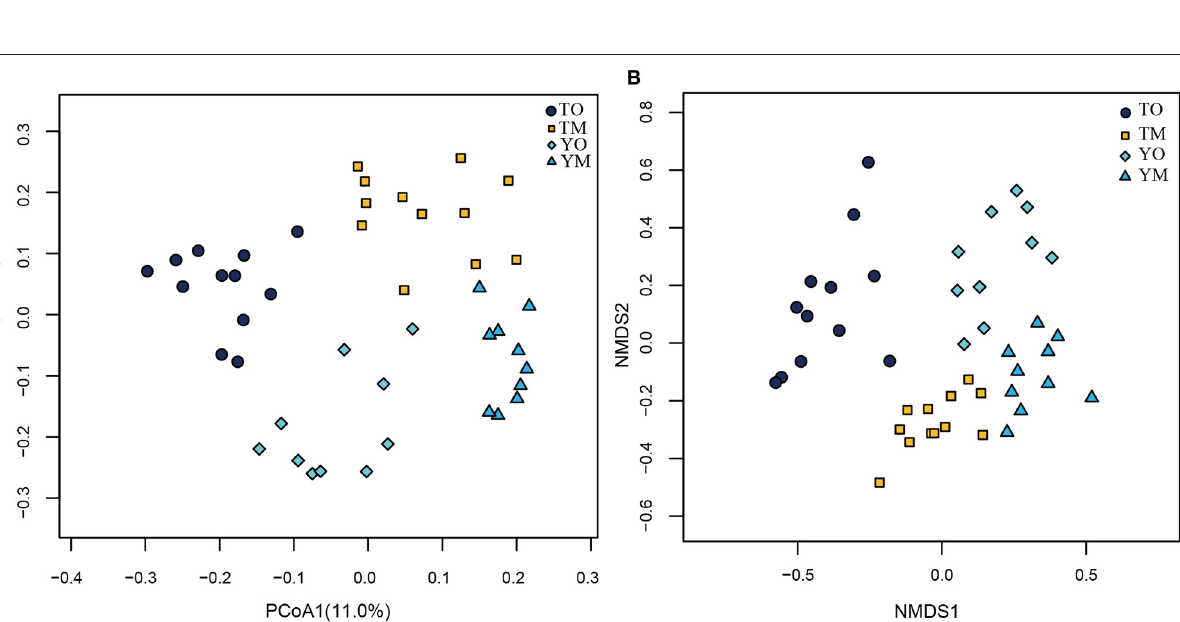
TABLE 2 | Differences in fungal community composition between the O and M horizons, based on PERMANOVA (P) in R adonis function and Anosim (A). Analysis